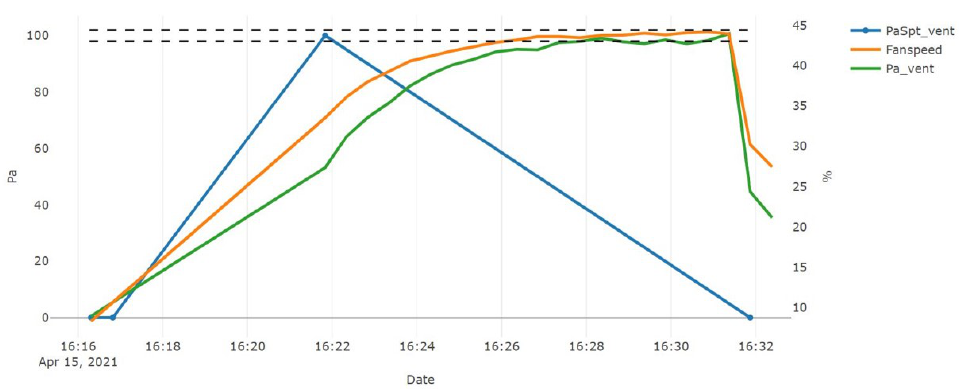
Figure 13. Time step response of the ventilation setup: stable condition.